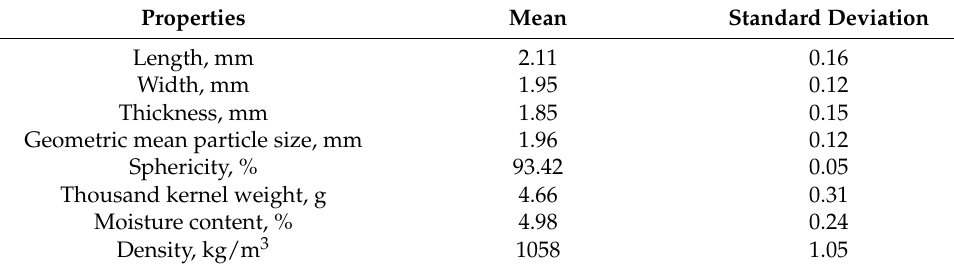
Table 1. Physical parameters of a rapeseed